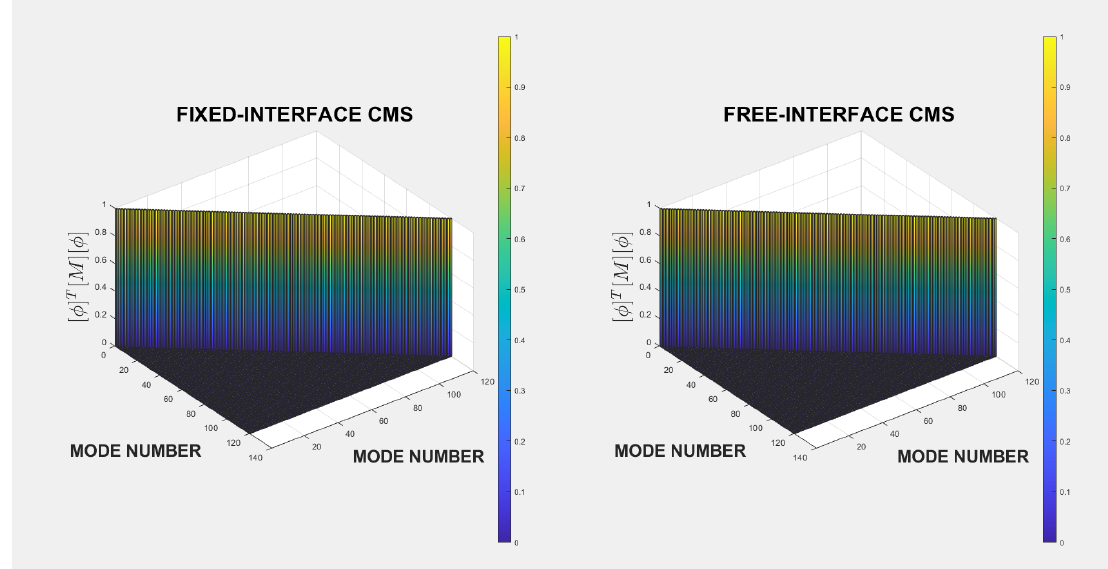
Figure 3. Modal Vector Orthogonality Checks of the Reduced-Order Models.